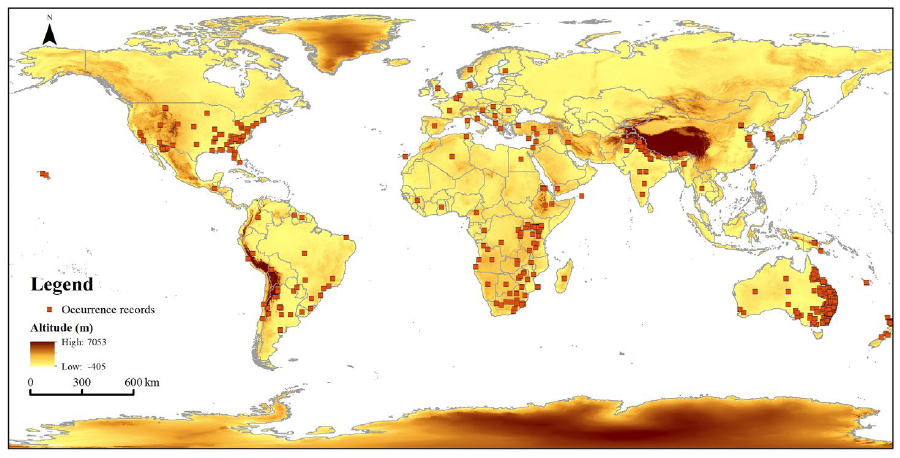
Figure 9. Occurrence records of Tagetes minuta L. in the world.